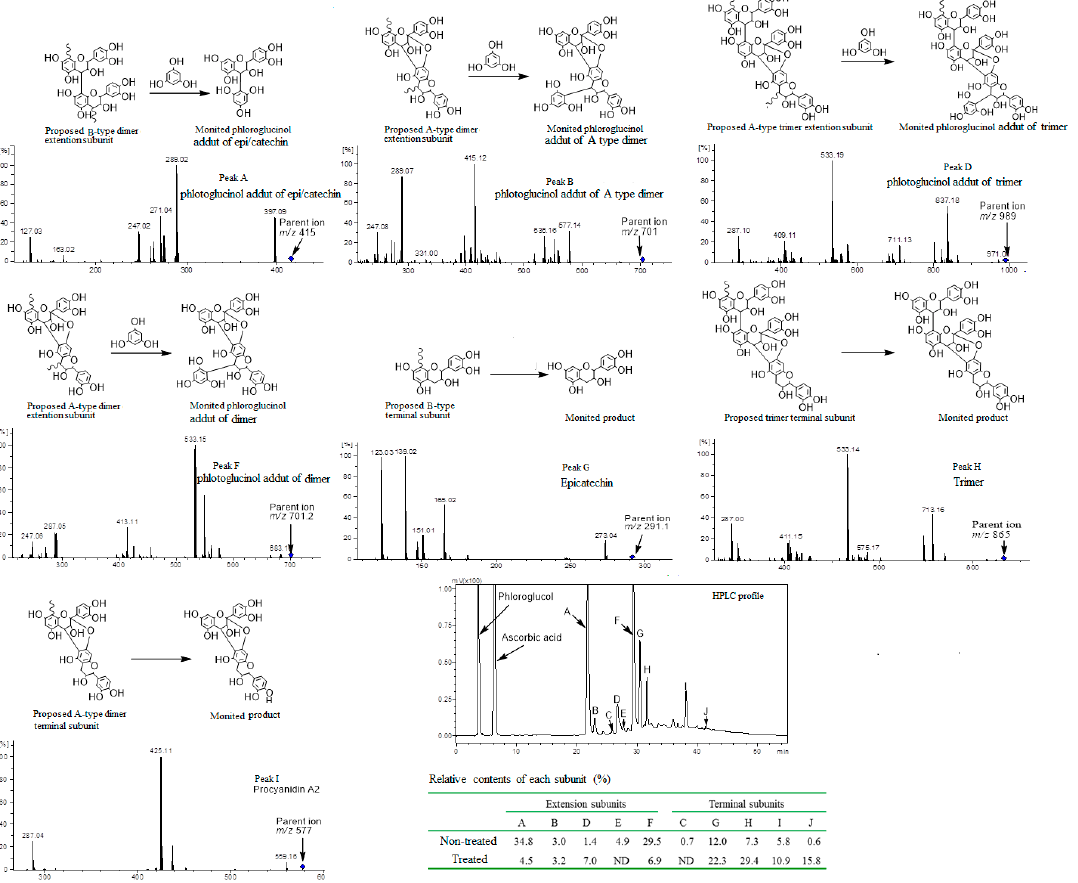
Figure 5. The structure changes of condensed tannin treated by A. awamori.